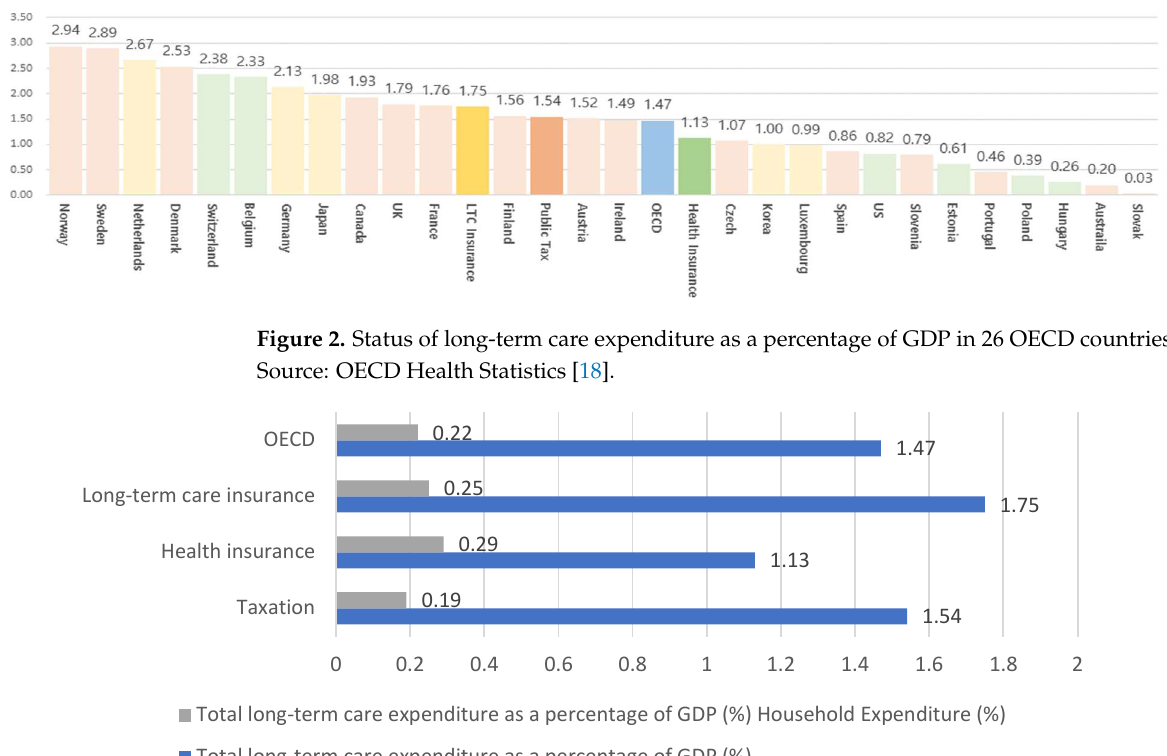
Figure 3. Total long-term care expenditure and household expenditure as a percentage of GDP [18,25].